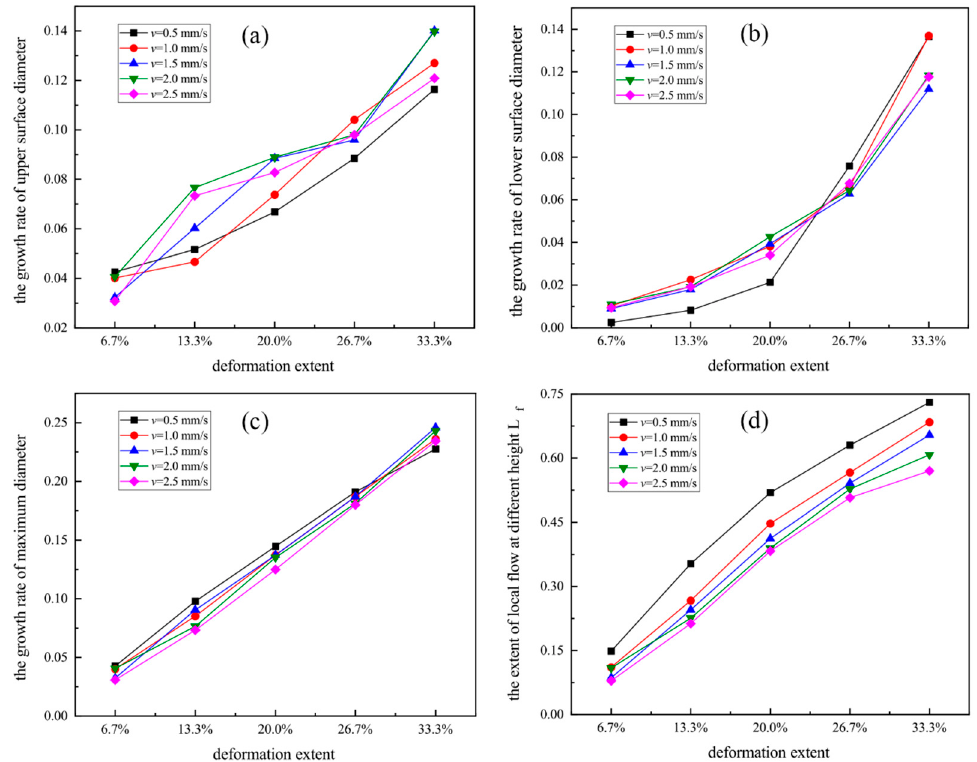
Figure 7. Influence of feed rate v of the lower dies on metal flow during the hot double-roll rotary forging process. ( a ) The growth rate of upper surface diameter. ( b ) The growth rate of lower surface diameter. ( c ) The growth rate of maximum diameter. ( d ) The extent of local flow at different heights L f .